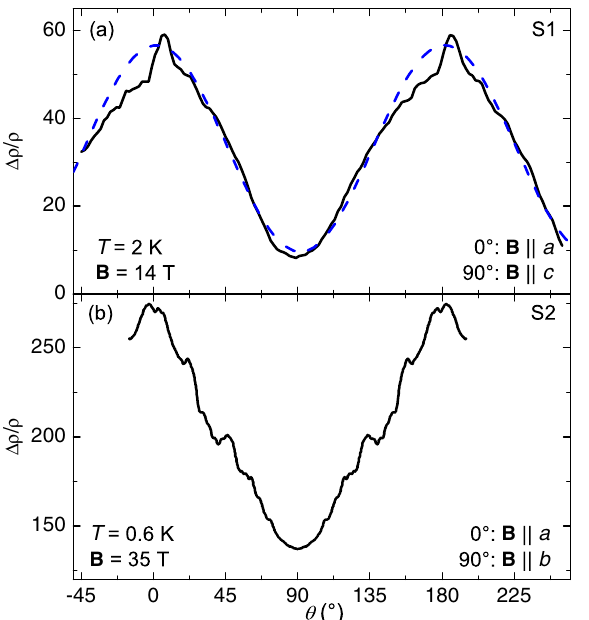
Fig. 3 MR as a function of angle at constant fi eld. Angle- dependent magnetoresistance for FeP samples a S1 and b S2 from Fig. 2 at magnetic fi elds of 14 and 35 T, respectively. The dashed line in ( a ) is a cosine fi t to the data with only the period fi xed, and the spike at maximum MR excluded. Data in ( b ) were originally taken only from − 15° to 110°, and so were mirrored around 90°.